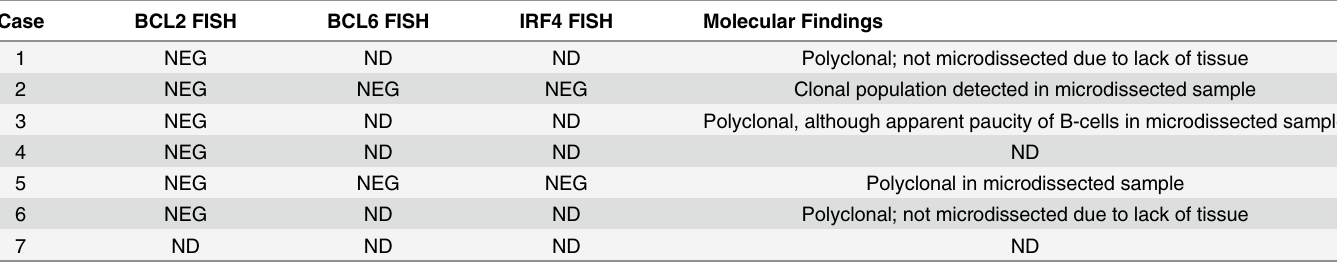
Table 4. Summary of FISH and Molecular Findings.